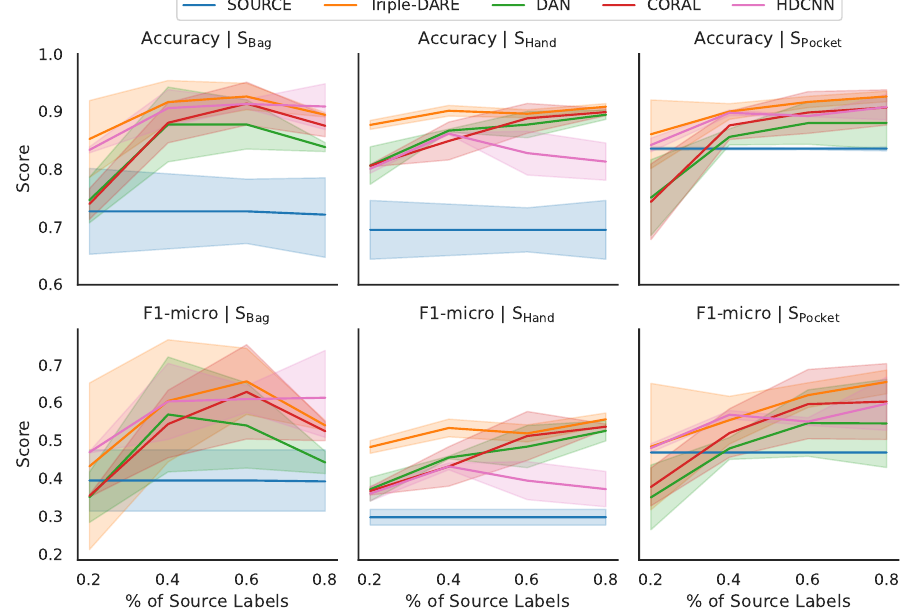
The highest scores are highlighted in bold font. Row colors match the colors used for different baseline methods throughout this article.